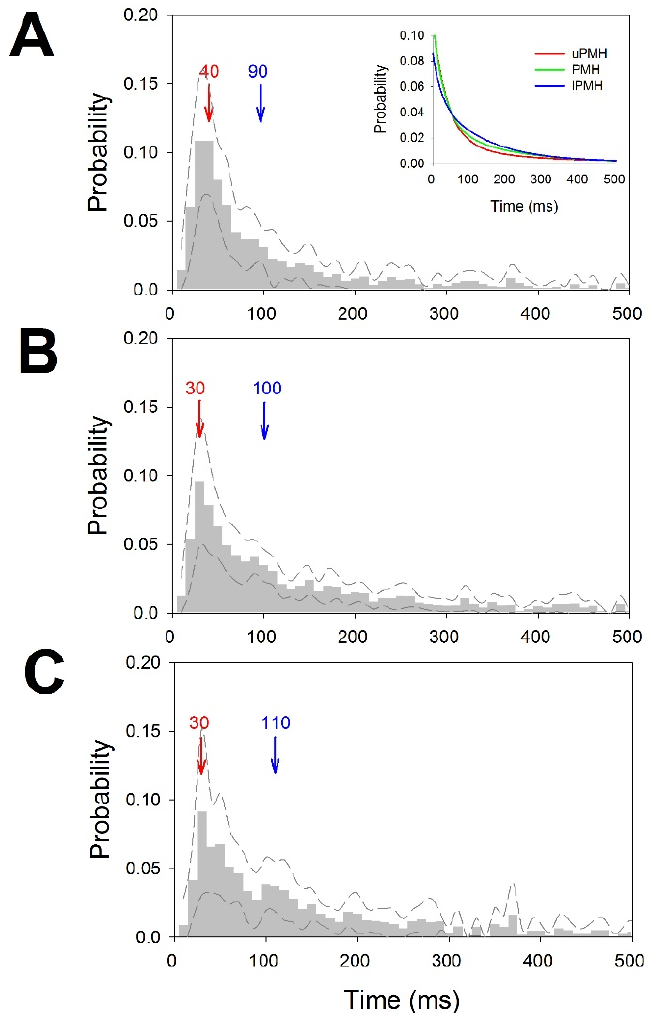
Figure 3. Probability mass functions for ISI distributions. ( A ) uPMH, ( B ) PMH and ( C ) lPMH. Dashed lines represent upper and lower ± 2.5 × SEM. Bin = 10 ms. Mode in red and median in blue. The inset in ( A ) represents the double-exponential fitted functions for uPMH (red), PMH (green) and lPMH (blue).